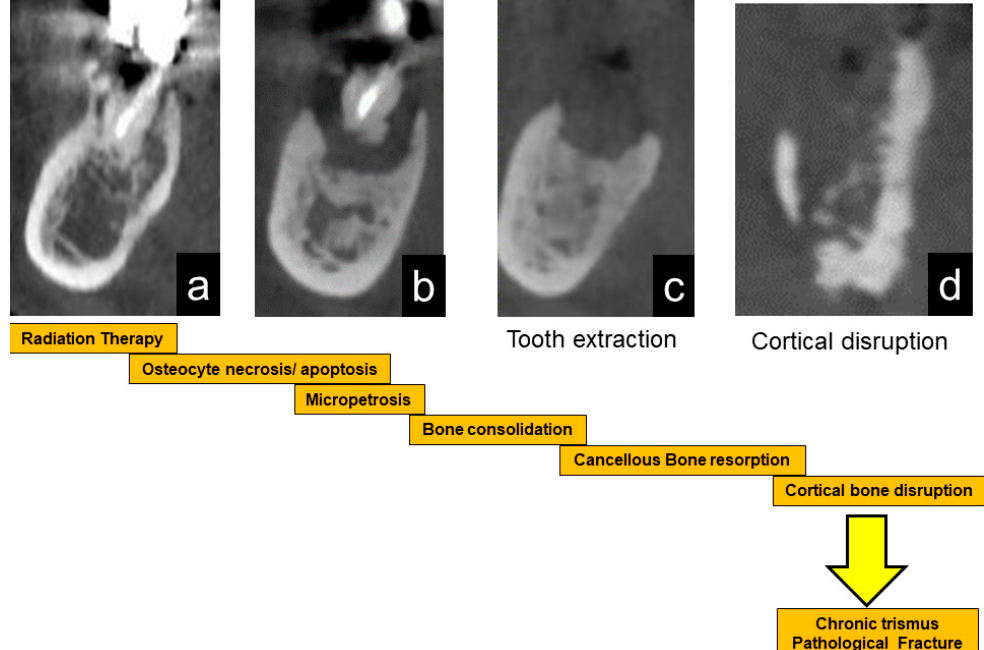
Figure 5. Schematic illustration of the progression of ORN. After radiation therapy, bone cells are damaged, leading to bone sclerosis ( a ). After that, the necrotic bone part is exposed ( b ). Stimulation such as tooth extraction causes infection and resorption of necrotic bone ( c ). When the cortical bone ruptures, inflammation spreads to the surrounding soft tissue, resulting in trismus ( d ). Eventually, it causes a pathological fracture.